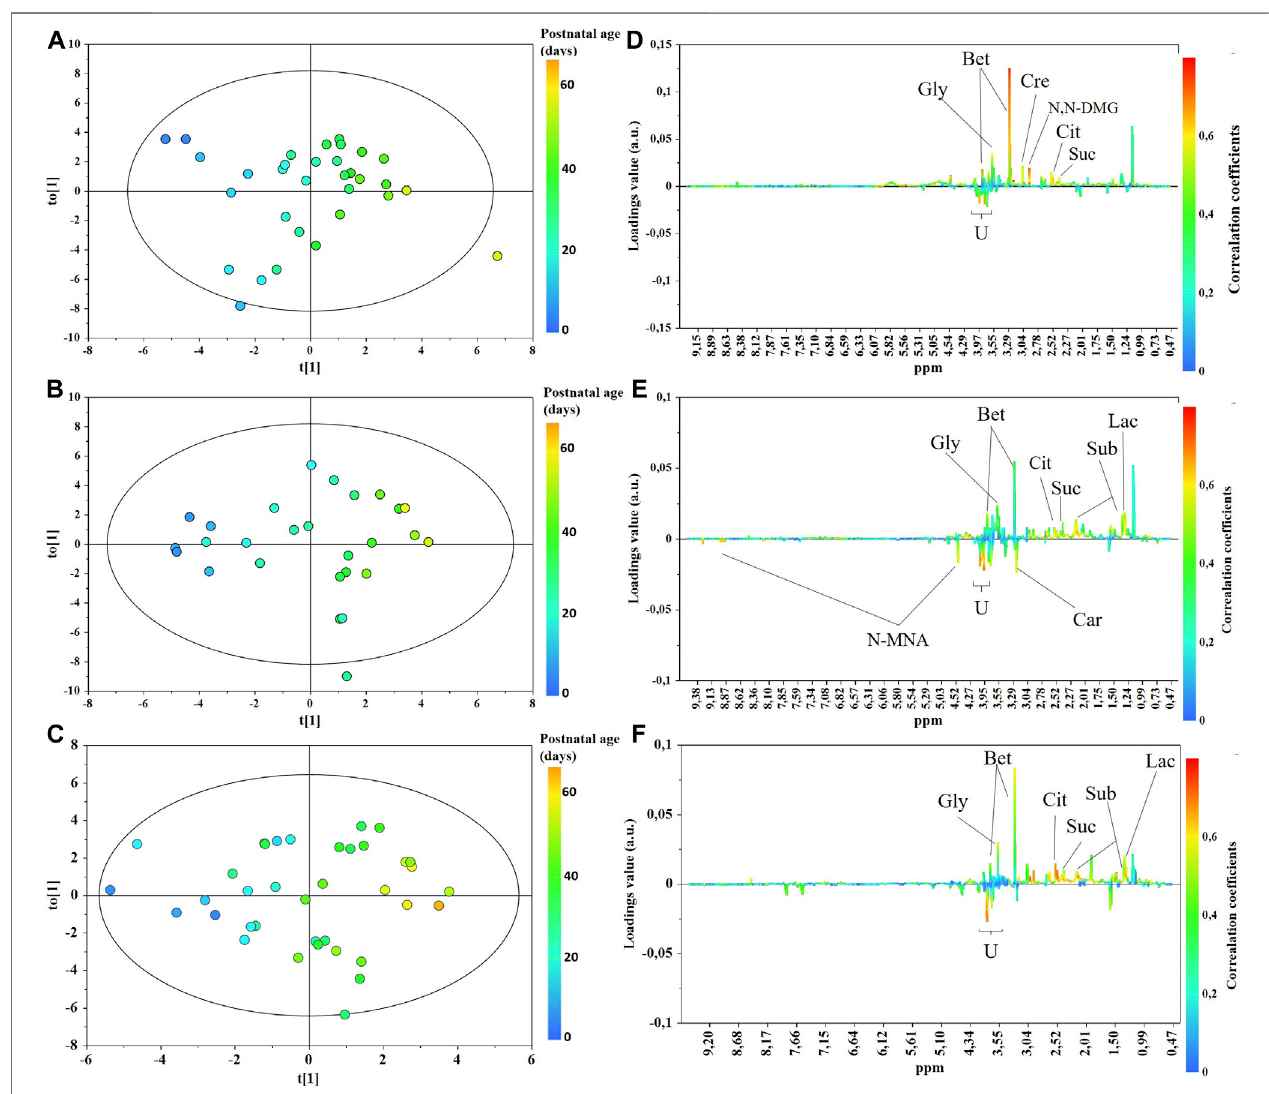
FIGURE3| OPLSscores (A – C) and loadingsline (D – F) plotsofthe 1 H-NMR urinespectrafrom controlgroup 3GDT (top) , group2FI (middle) ,and group1NEC (bottom) . The scores are coloured according to the postnatal age. Abbreviations: Bet, betaine; Car, carnitine; Cre, creatinine; Cit, citrate; N,N -DMG, N,N - dimethylglycine; N -MNA, N -methylnicotinamide; Gly, glycine; Lac, lactate; Sub, suberate; Suc, succinate.